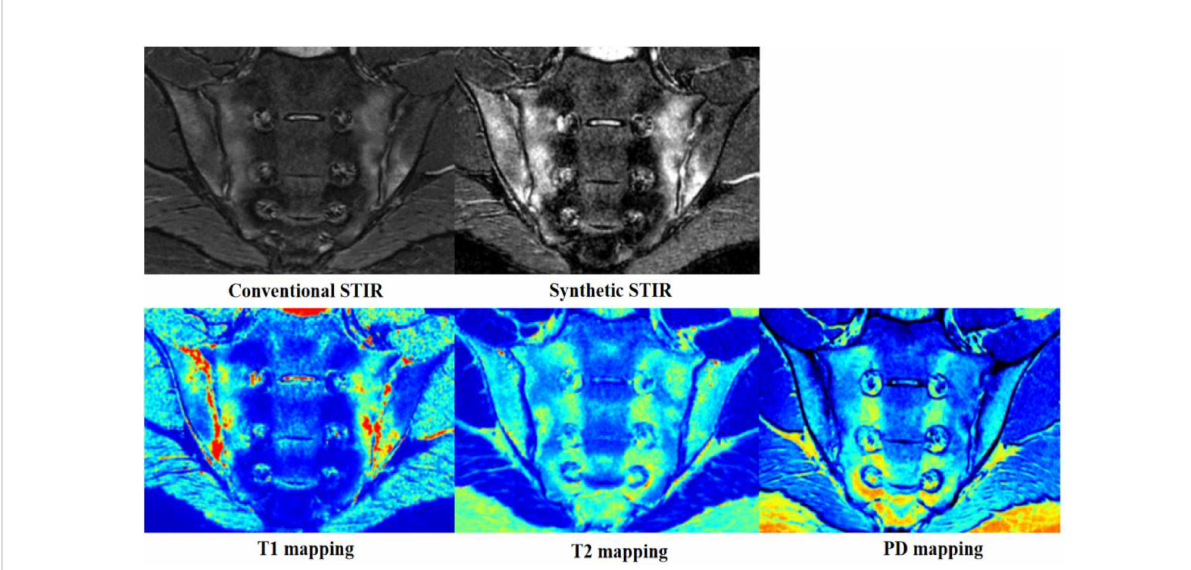
FIGURE 4 Images from a 19-year-old man with axial spondyloarthritis (axSpA) who presented with a 1-year history of in fl ammatory back pain and who was human leukocyte antigen B27 (HLA-B27) positive. Conventional and synthetic short time of inversion recovery (STIR) images show severe bone marrow edema (BME) in the bilateral sacroiliac joints. The corresponding areas are green, yellow, and red on T1 mapping; green-yellow on T2 mapping; and blue and wathet blue on proton density (PD) mapping.